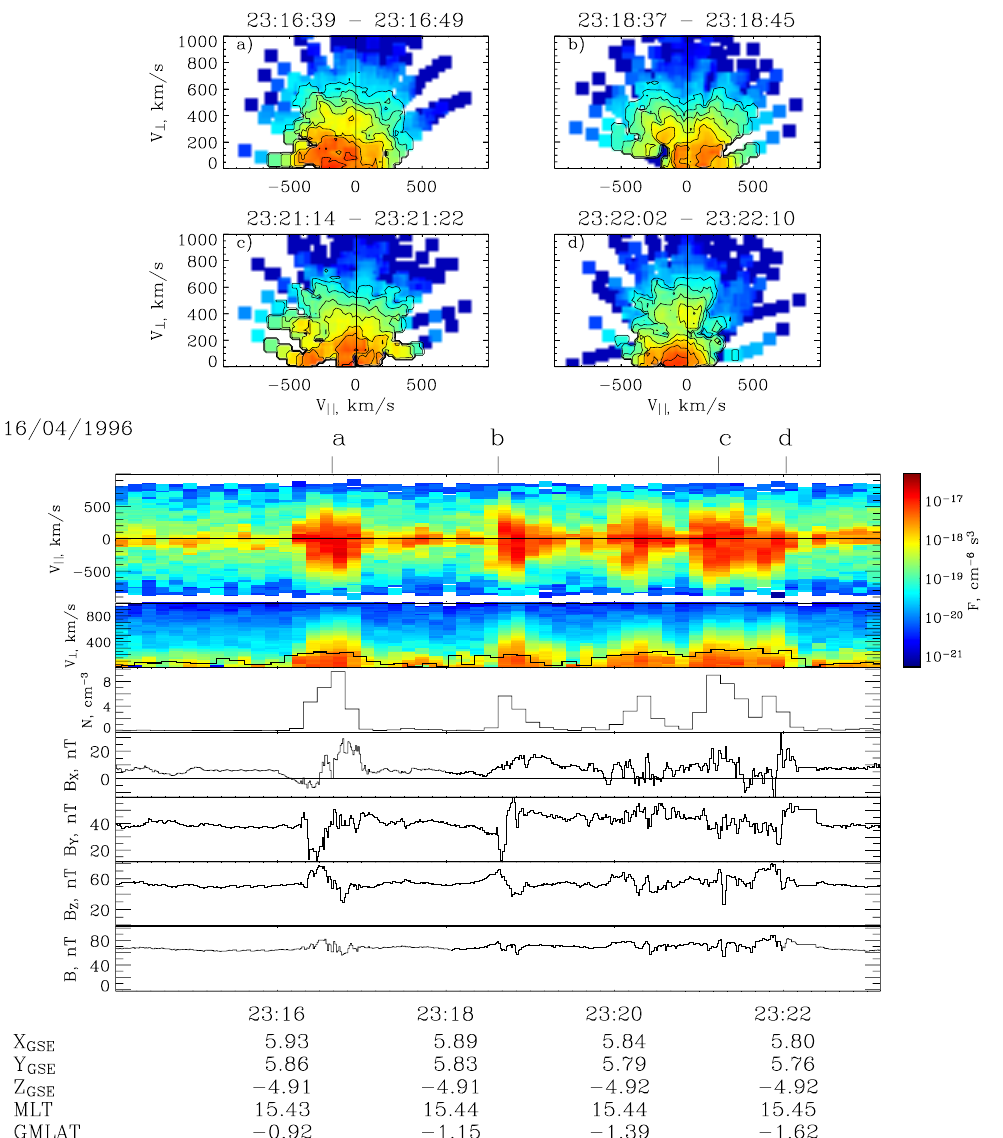
Fig. 15. Four representative ion velocity distributions within a set of transients observed within the LLBL on 16 April 1996 (top). V k -time and V ⊥ -time spectrograms, number density and magnetic field data are shown on the bottom. Times for velocity distributions are shown by tick marks. See Fig. 10 caption for more